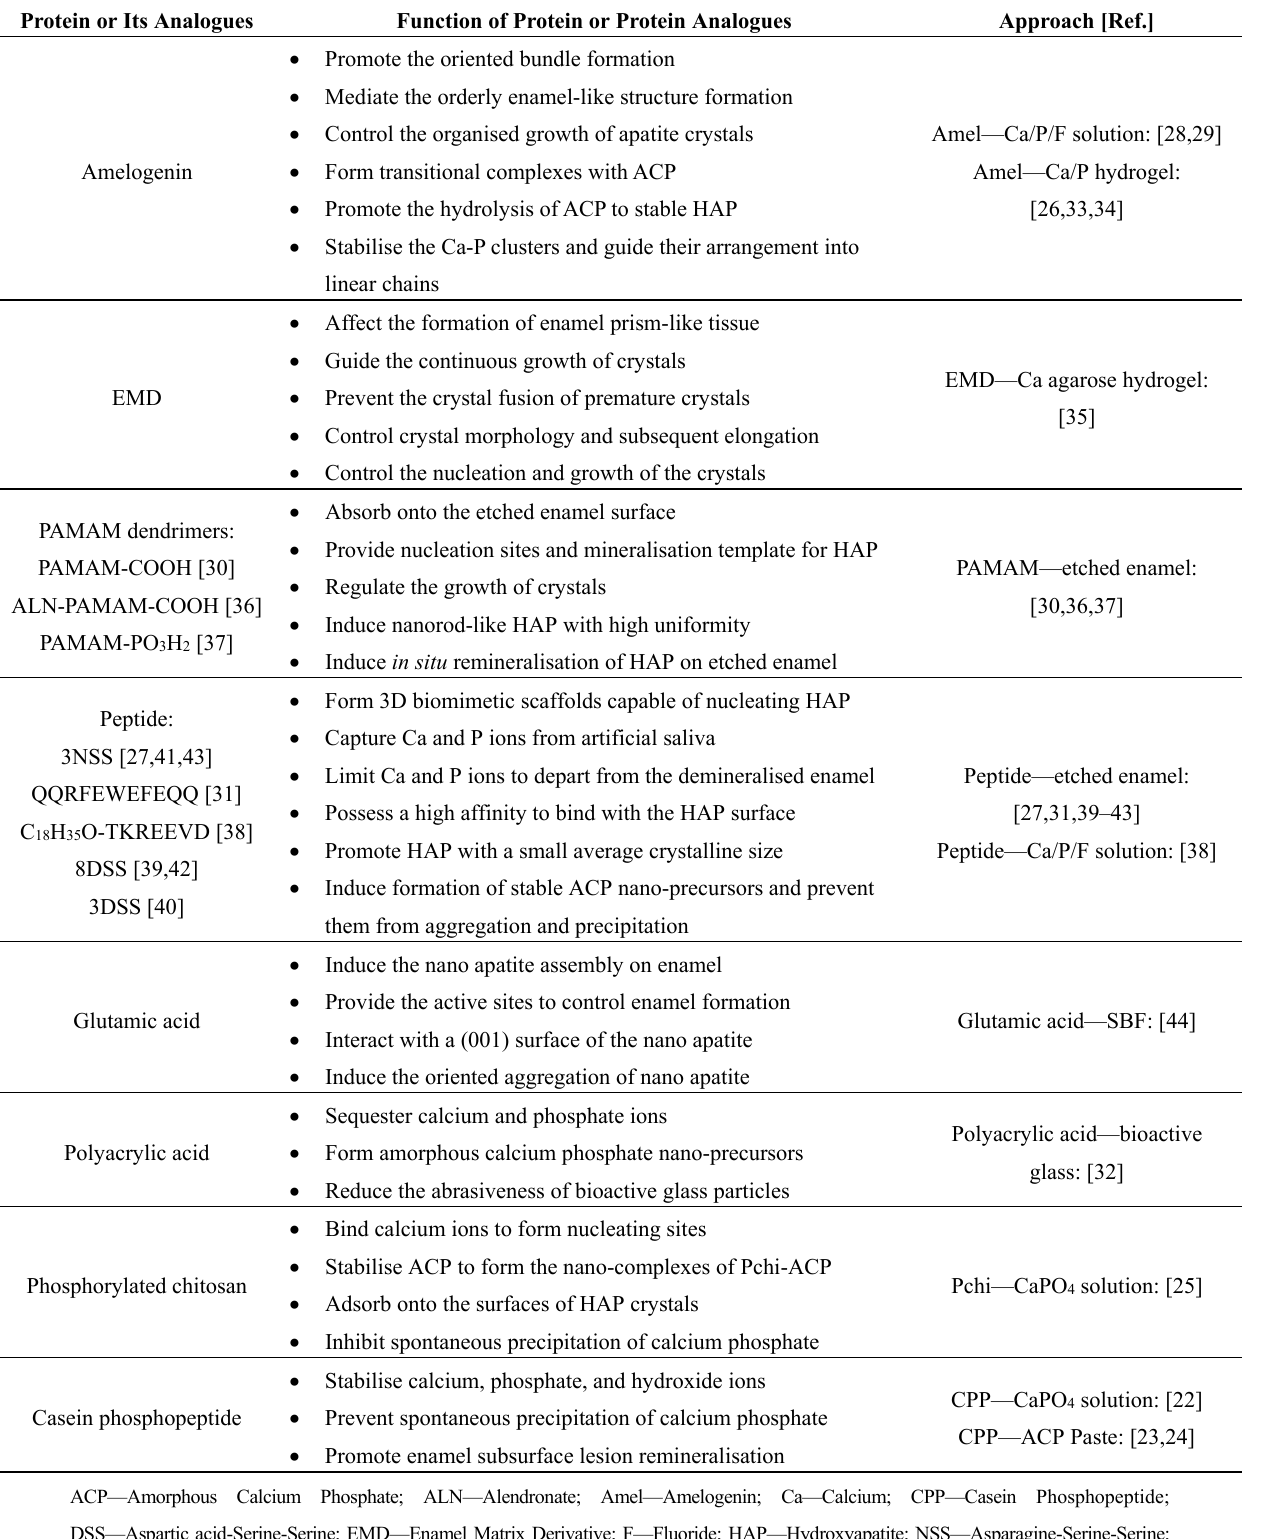
Table 2. Protein or its analogues and their functions in biomimetic mineralisation of human enamel. Protein or Its Analogues Function of Protein or Protein Analogues Approach